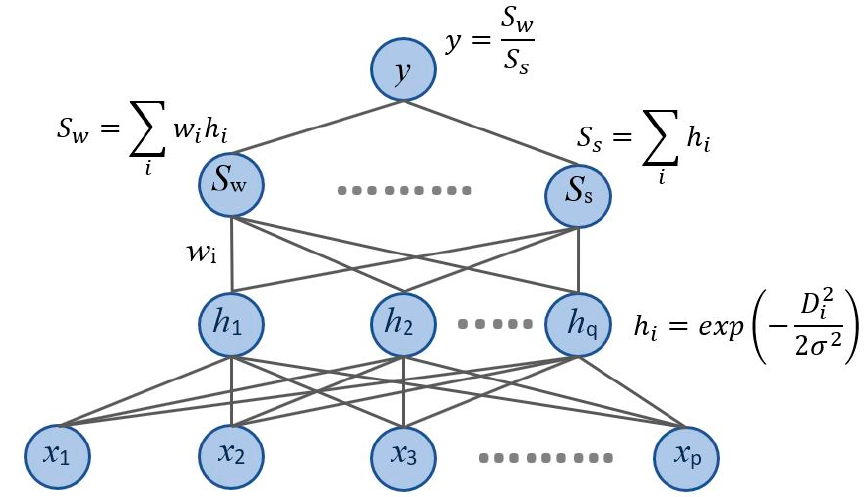
Figure 1. Typology of a generalized regression neural network (GRNN).